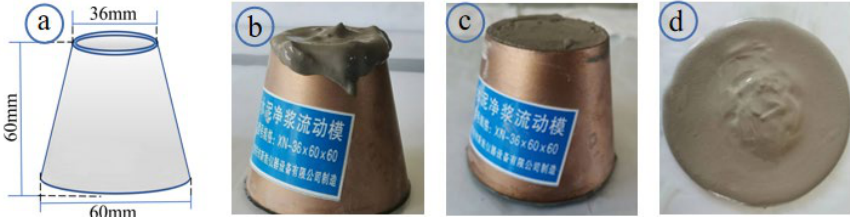
Figure 4. Paste diffusion test process: ( a ) prepare a slump cone with the height of 60mm and the diameter of 36 mm, 60mm, respectively; ( b ) grout; ( c ) trowl; ( d ) measure.